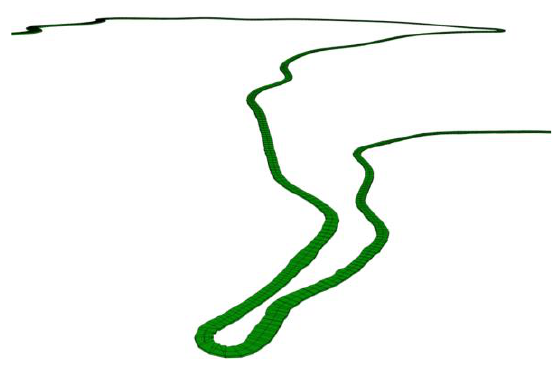
Figure 16. IFC roadway: alignment and